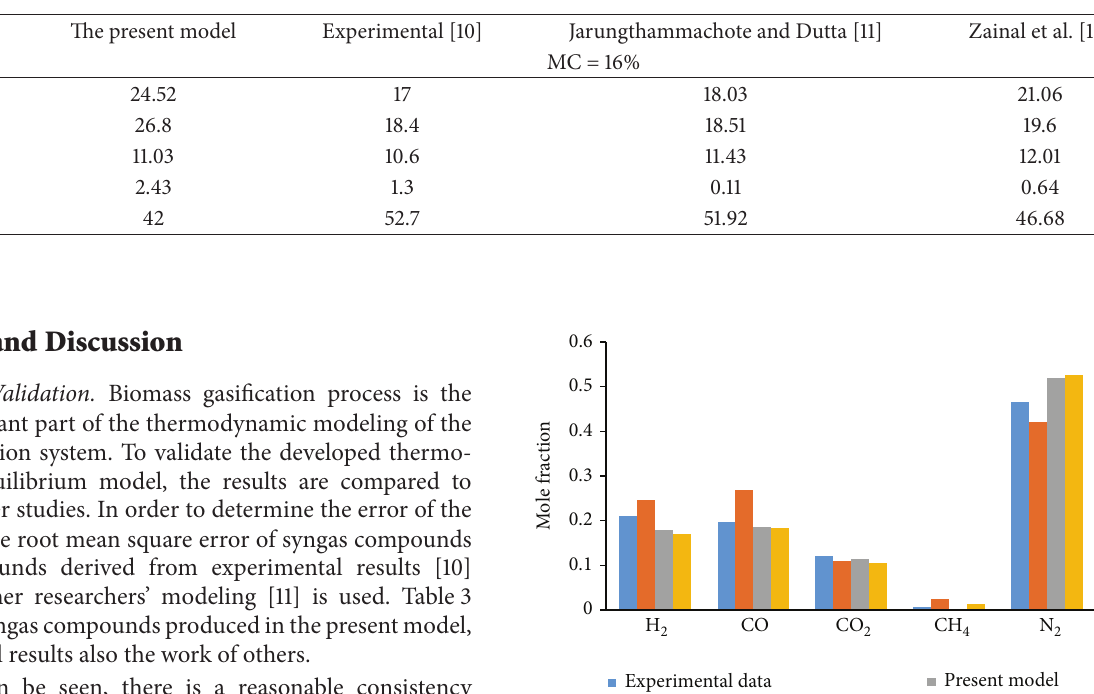
Table 3: A comparison of the modeling syngas composition and experimental result.